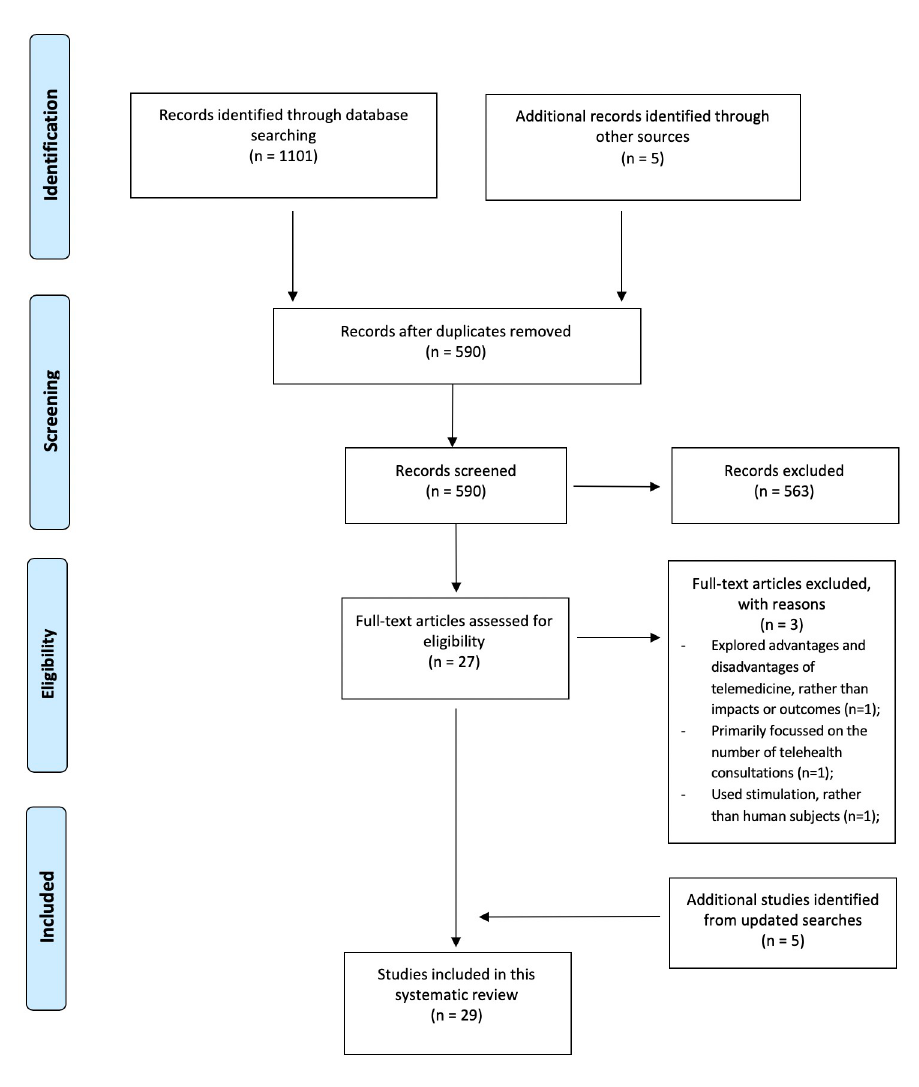
Fig 1. PRISMA flow